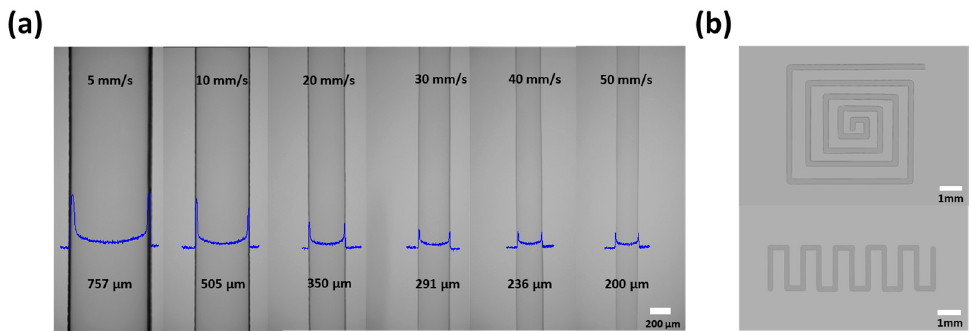
Figure 2. ( a ) Optical Microscope (OM) images of ZTO solution line patterning by the cone-jet mode of EHD jet printing method according to the printing speed (blue line shows the cross-sectional profile of line patterns). ( b ) Various shapes of patterns derived using the 50 mm/s condition of EHD jet printing.